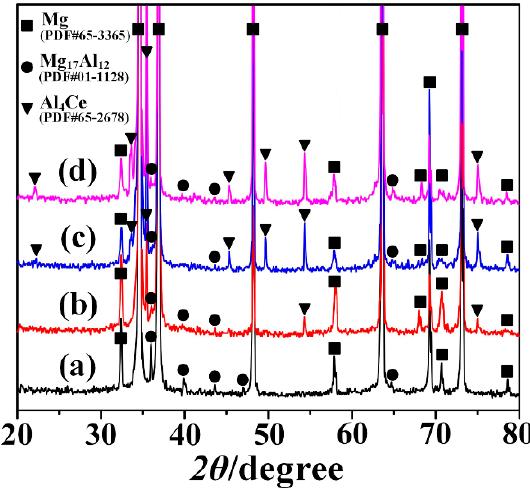
Figure 3. The X-ray diffraction spectra of the as-extruded AZ80- x Ce alloys: ( a ) x = 0; ( b ) x = 0.2; ( c ) x = 0.8; ( d ) x = 1.4. ( c ) x = 0.8; ( d ) x =